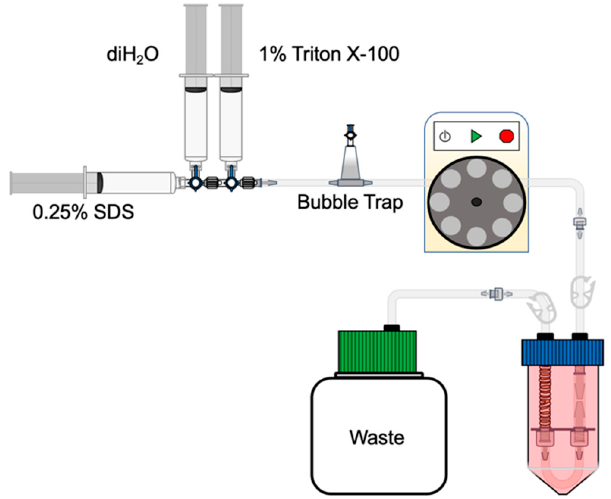
Figure 3. Decellularization. The bioreactor was connected in series to a peristaltic pump and the waste chamber. A protocolized regimen of detergents was perfused through the lumen of the trachea as follows: 0.25% SDS, diH 2 O, and 1% Triton X-100 at 5 mL/min for 8 min each at 37 °C. The trachea was then luminally washed with 1X DPBS at 5 mL/min for 50 min at 37 °C, followed by a 48-h wash at 4 °C.